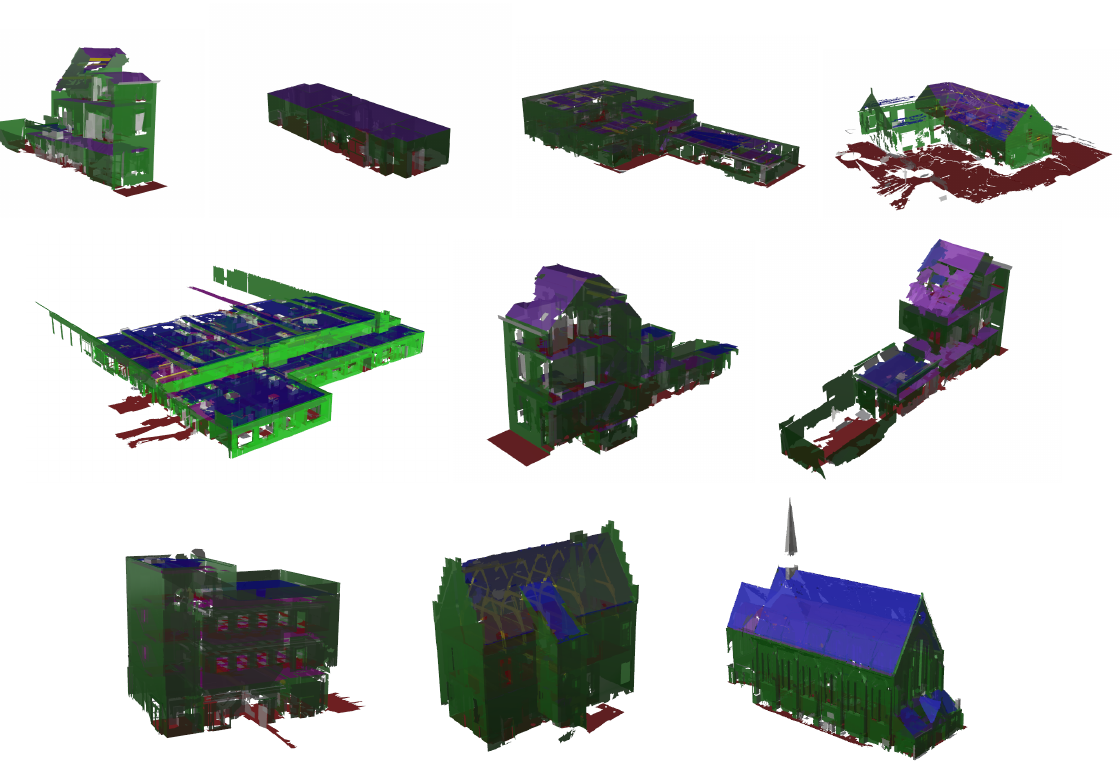
Figure 1: Used test cases for the model evaluation. The test data includes houses, offices, factories, a castle and a